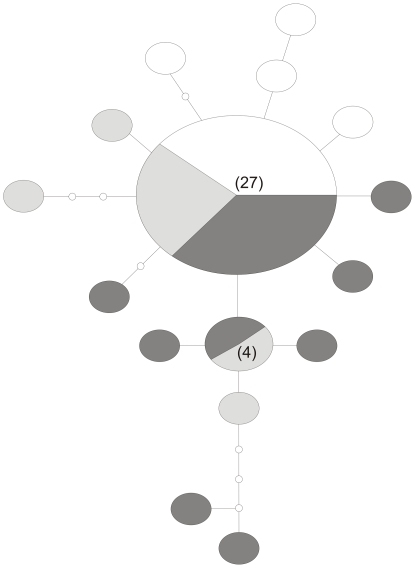
Haplotype network for the mtDNA cox1 dataset for Cryptopygus antarcticus travei from Marion Island.Each large circle represents a unique haplotype and each line represents one mutational step. Numbers in parentheses indicate haplotype frequency (when >1), while ‘’ indicates an inferred or missing haplotype. Shading indicates whether individuals with that haplotype have low (<0.010 µlO2.µg−1.hr−1; white), medium (0.0010≤x≤0.0020 µlO2.µg−1.hr−1; light grey) or high (>0.0020 µlO2.µg−1.hr−1; dark grey) metabolic rates. This figure is not to scale.